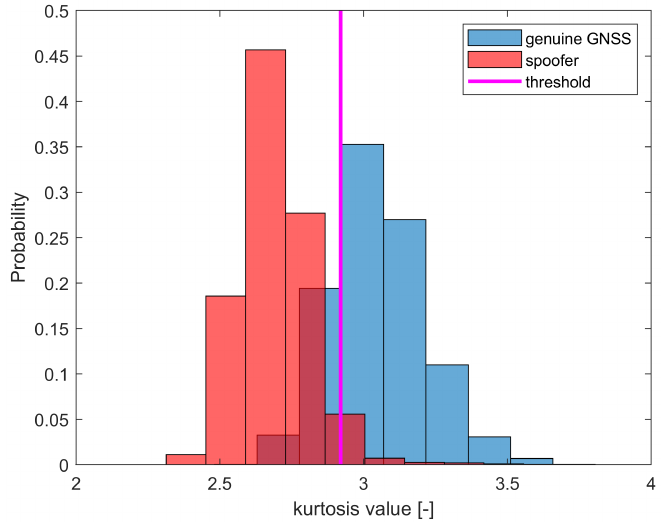
Figure 11. Example of the Galileo E1 and spoofer histograms when kurtosis is applied as a feature